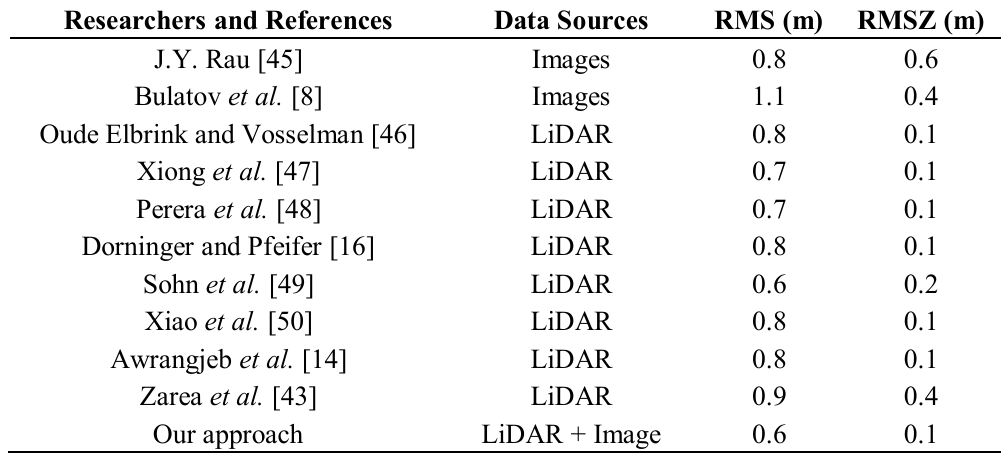
Table 1. The building reconstruction results of different research institutes in test Area